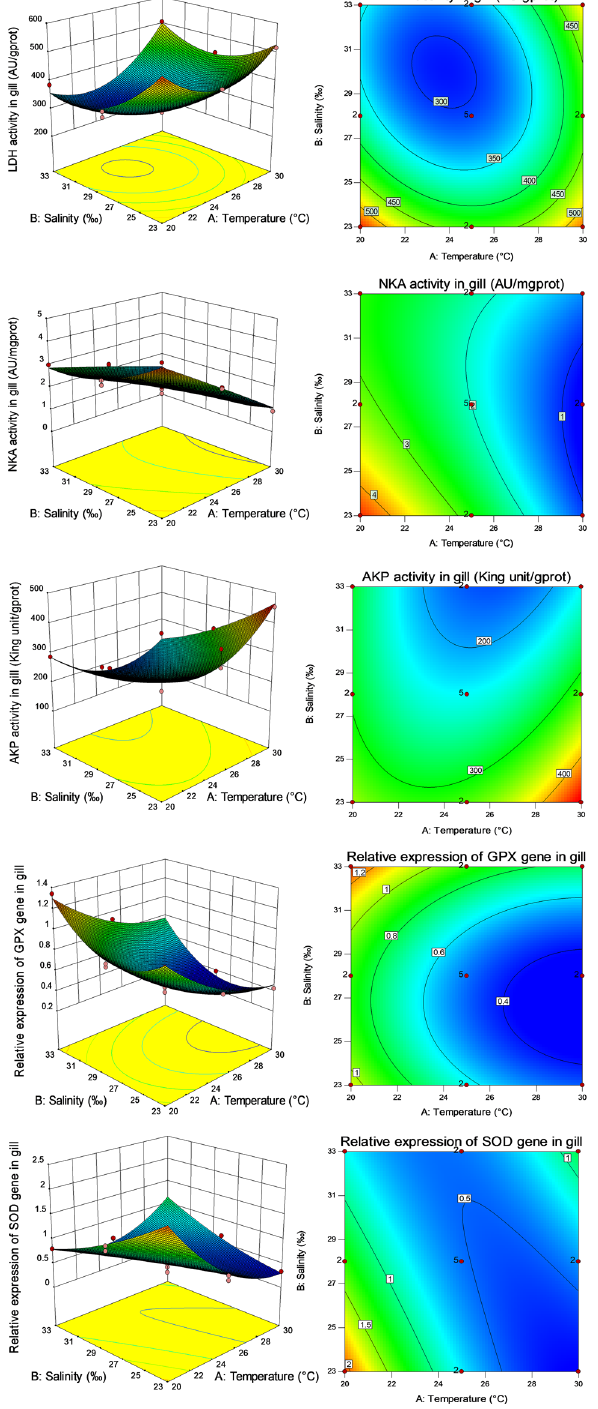
Figure 2. Response surface (left) and contour map (right) of salinity and temperature to respiratory metabolic enzyme activities and gill immune gene relative expression of P. fucata . The activities of LDH, NKA and AKP, and the relative expression levels of GPX and SOD genes in gills were shown from top to bottom. The heat map in Fig. 2 was generated using Design Expert (https:// www. state ase. com/ softw are/ design- expert/, version 10.0.7.0 32-bit)